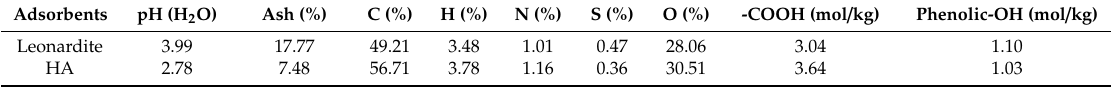
Table 1. The selected properties of leonardite and leonardite-derived humic acid (HA).